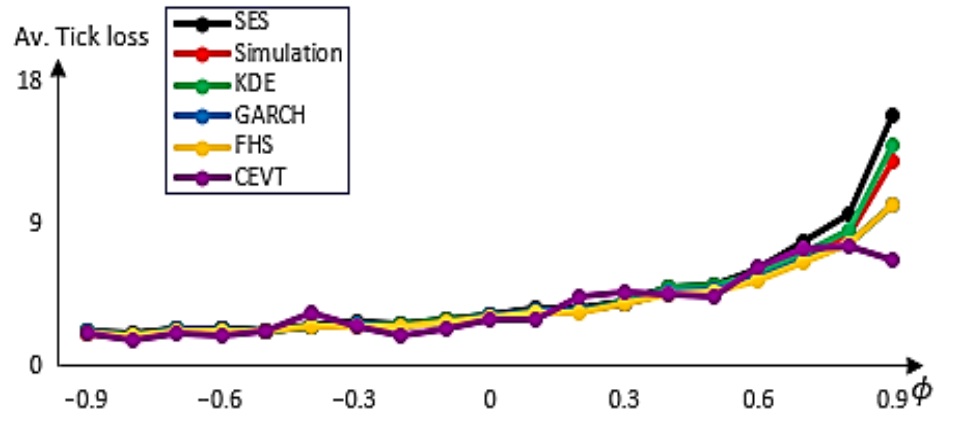
Figure 2. Average tick loss values for lead times of four weeks, when forecasting errors follow a lognormal distribution.